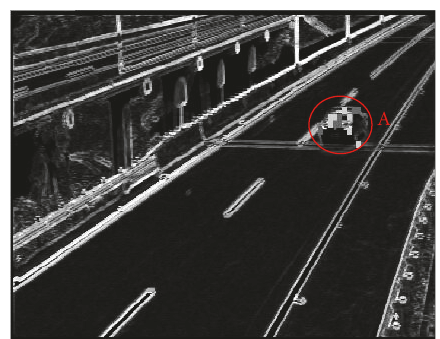
Figure 27: Status difference of different blocks in the abnormal area.